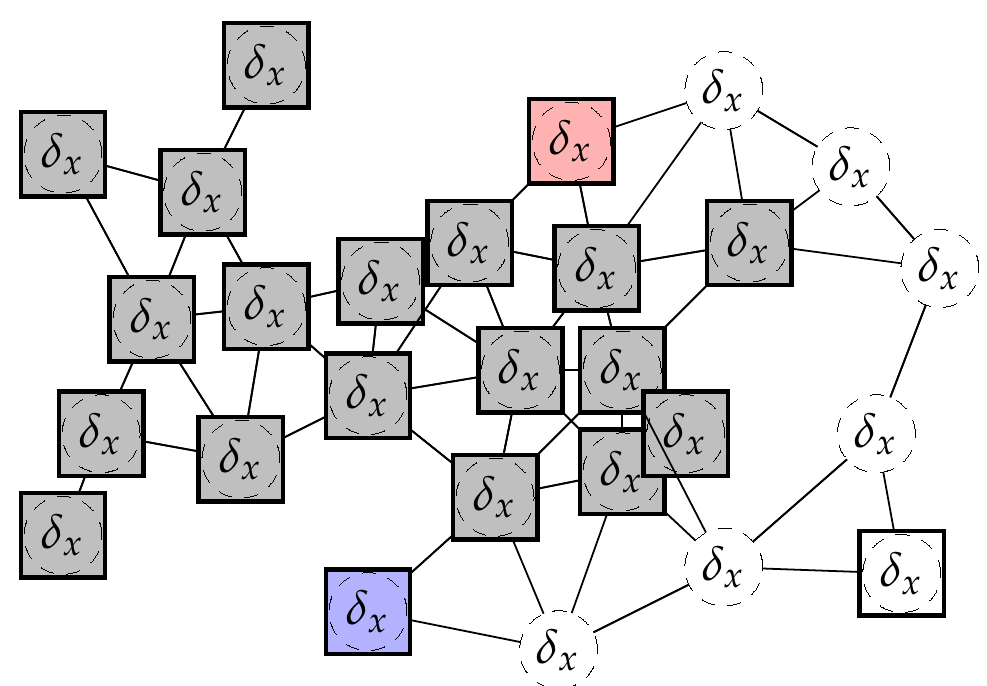
Figure 2. Pictorial representation of the crowd-aware navigation scenario. Physical devices are depicted with a solid square, logical devices are depicted with a dashed circle; an overlap of the two indicates that a logical device is associated to a physical device, a circle outside any box denotes a purely virtual device. Nodes sensing overcrowding are depicted in grey, the requester is coloured in blue, and the PoI is filled in red. The requester desires to reach the red device, walking along a path that can avoid overcrowded areas. Considering solely the physical devices as part of the system, no available route can be computed in a self-organising way; however, by populating the system with virtual nodes, a route circumventing the problematic area can still be found. The system could also (in principle) continuously look at strategies to self-improve such an integration for non-functional benefits.